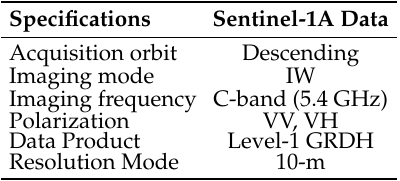
Table 2. General information about the considered SAR